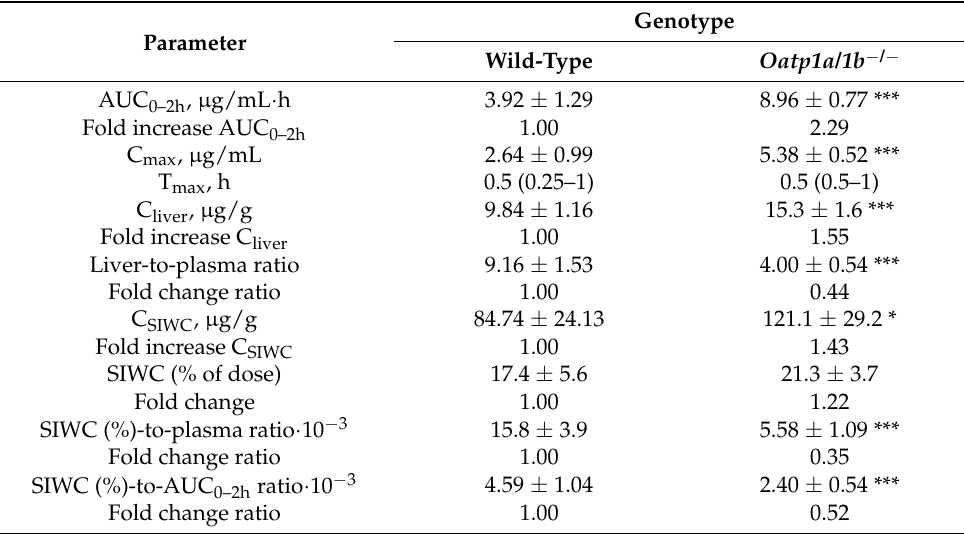
Table 3. Plasma, brain, liver, and small intestine pharmacokinetic parameters of repotrectinib in female wild-type, Cyp3a − / − and Cyp3aXAV mice over 8 h after oral administration of 10 mg/kg repo- trectinib. Table 2. Plasma, liver, and small intestine with content (SIWC) pharmacokinetic parameters of repotrectinib in male wild-type and Oatp1a/1b − / − mice over 2 h after oral administration of 10 mg/kg repotrectinib.